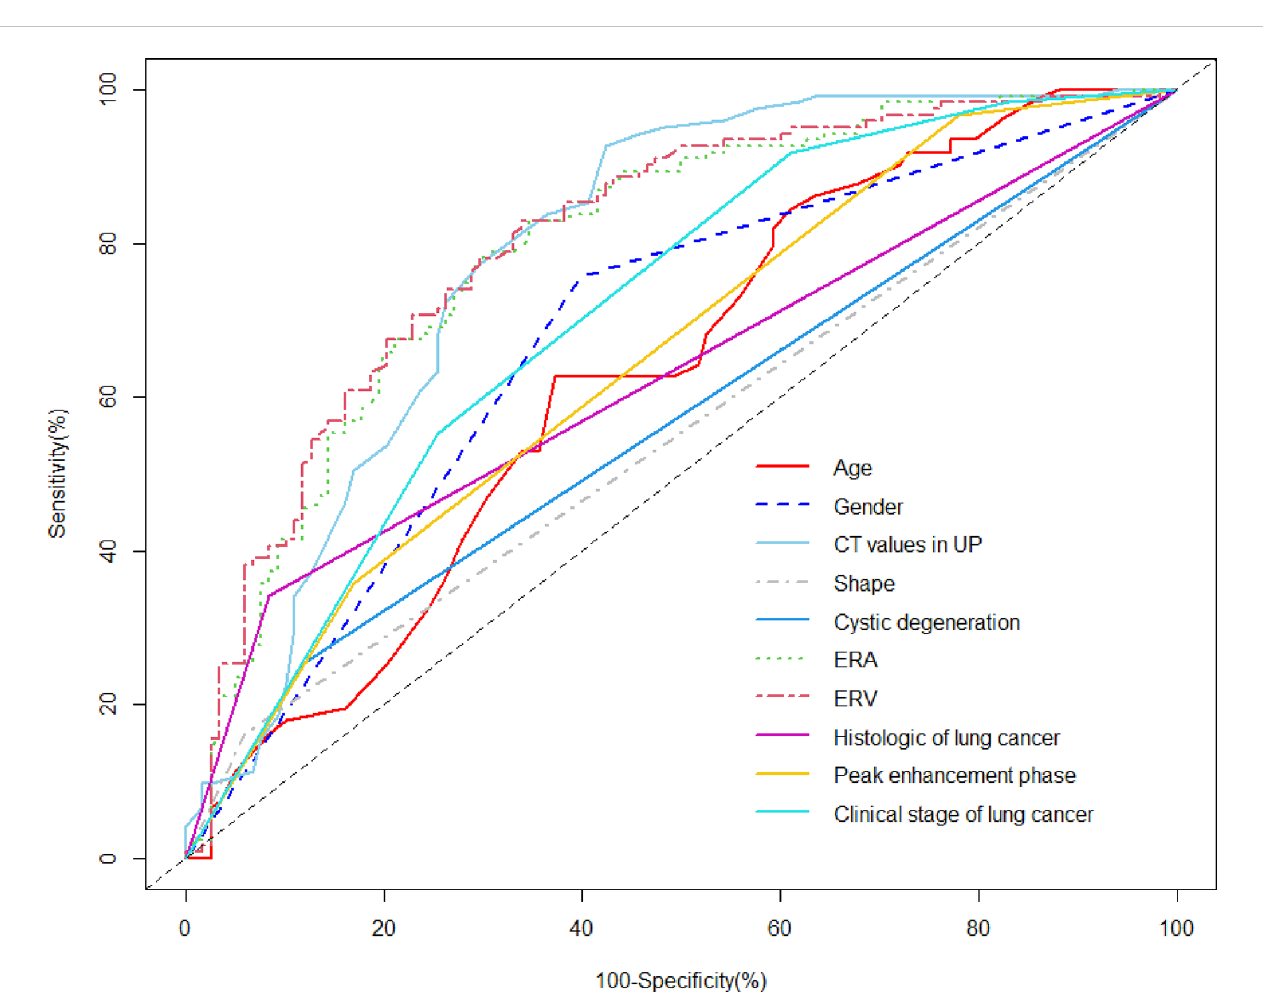
FIGURE 2 ROC analysis using signi fi cant individual variables for differentiation of metastases from LAPs. The AUC of age, CT values in UP, ERA, ERV, gender, shape, cystic degeneration, histology of lung cancer, peak enhancement phase, and clinical stage of lung cancer was 0.630, 0.789, 0.795, 0.805, 0.679, 0.552, 0.567, 0.628, 0.651, and 0.710, respectively. ERV showed a higher AUC than other individual variables.